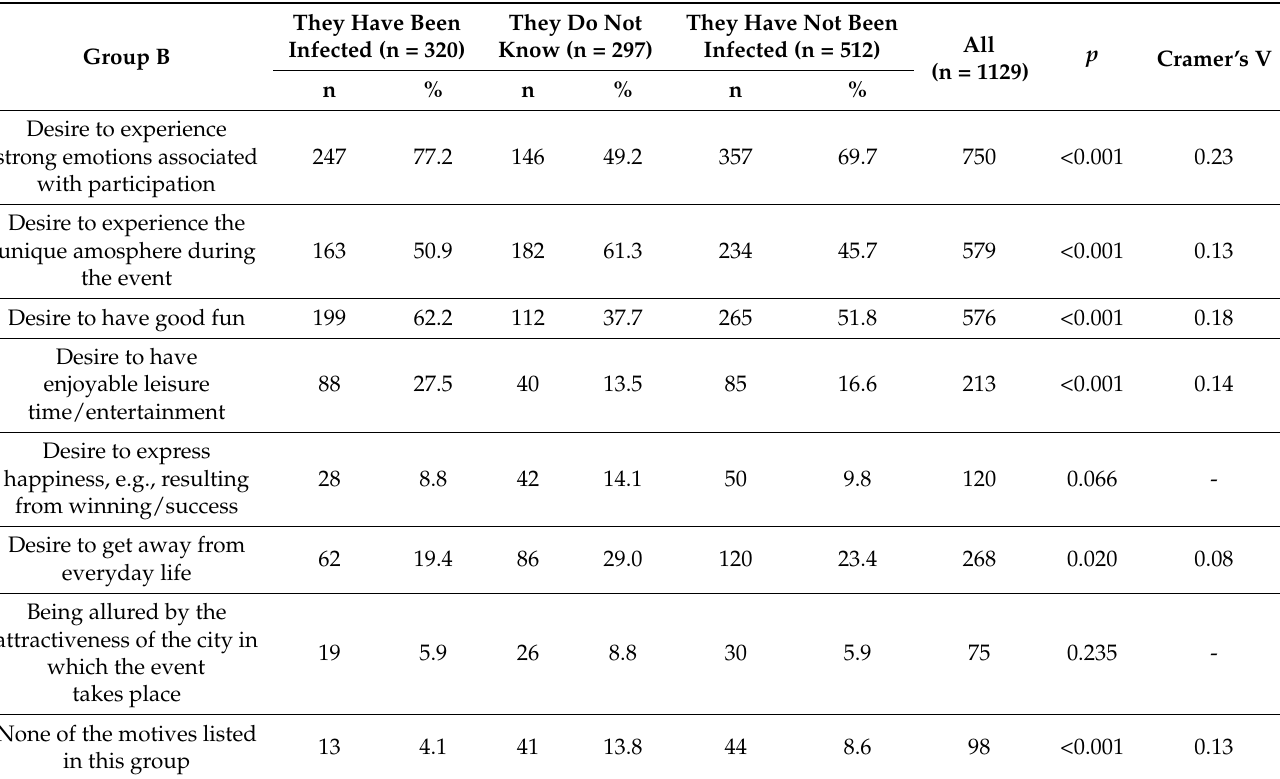
Table 3. Motives within the scope of experience orientation versus COVID-19